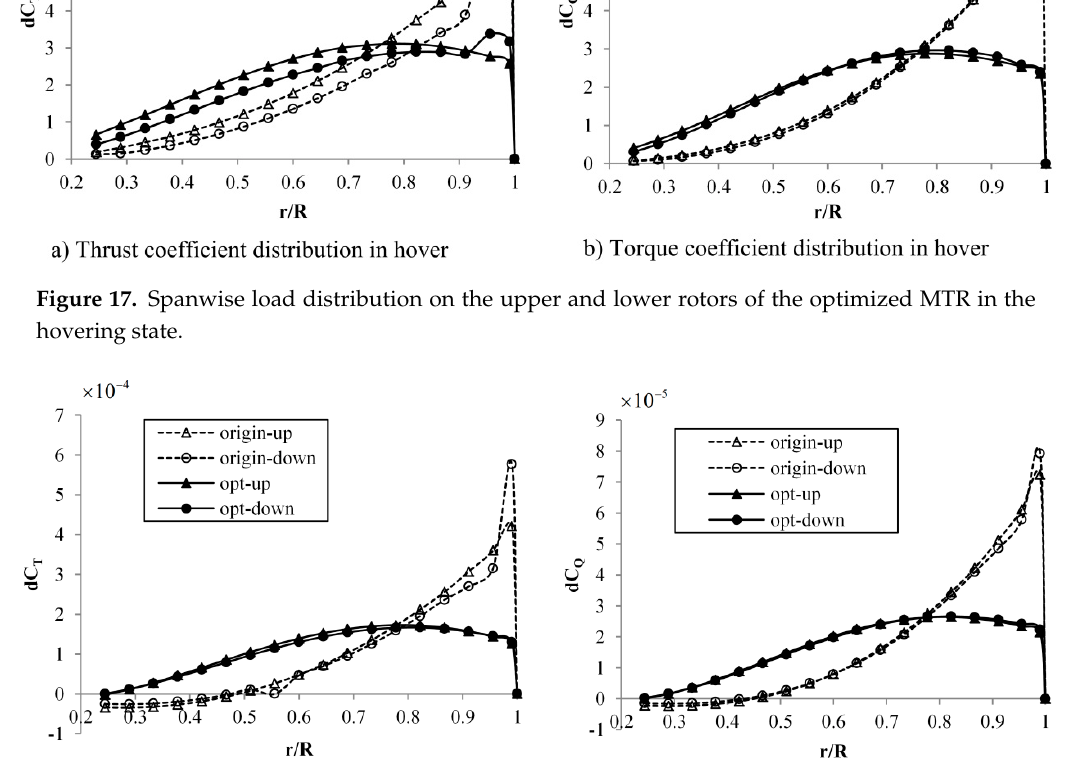
Figure 18. Spanwise load distribution on the upper and lower rotors of the optimized MTR in the cruising state.